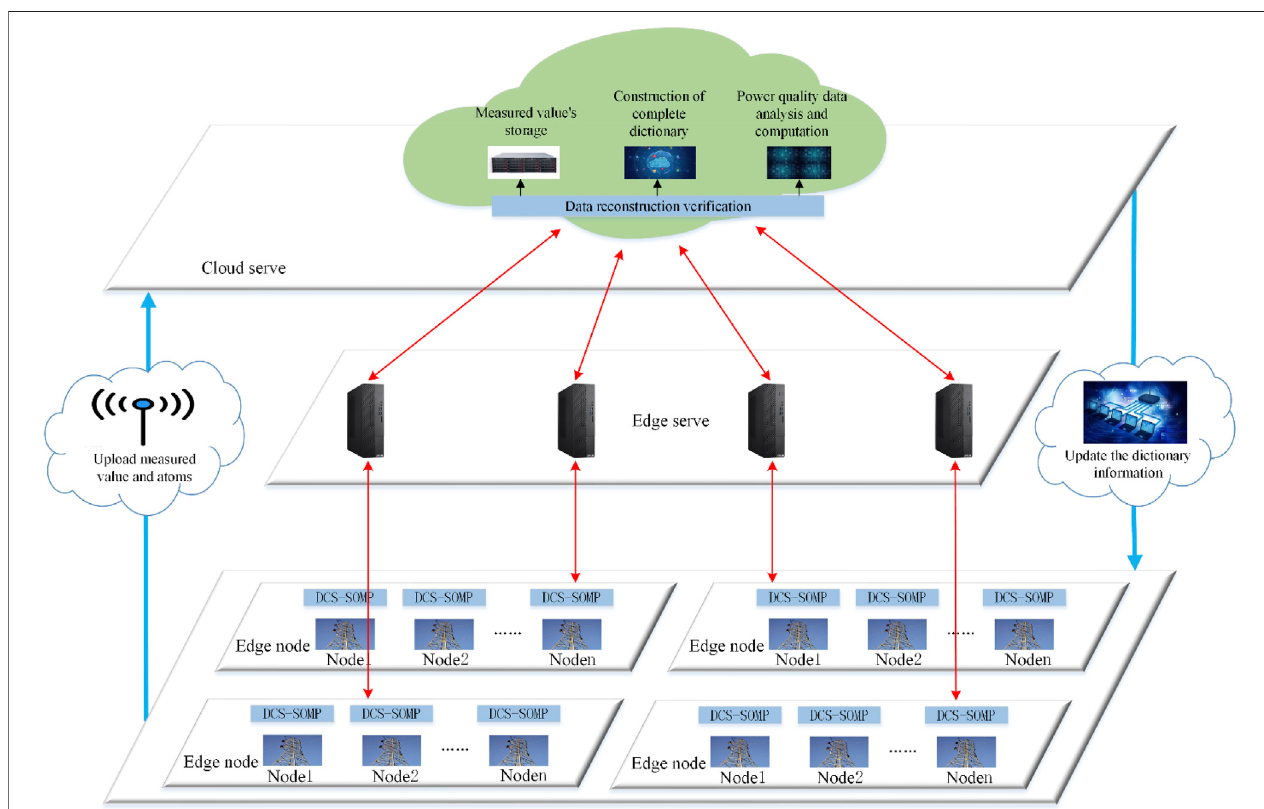
FIGURE 2 | Cloud-edge collaboration